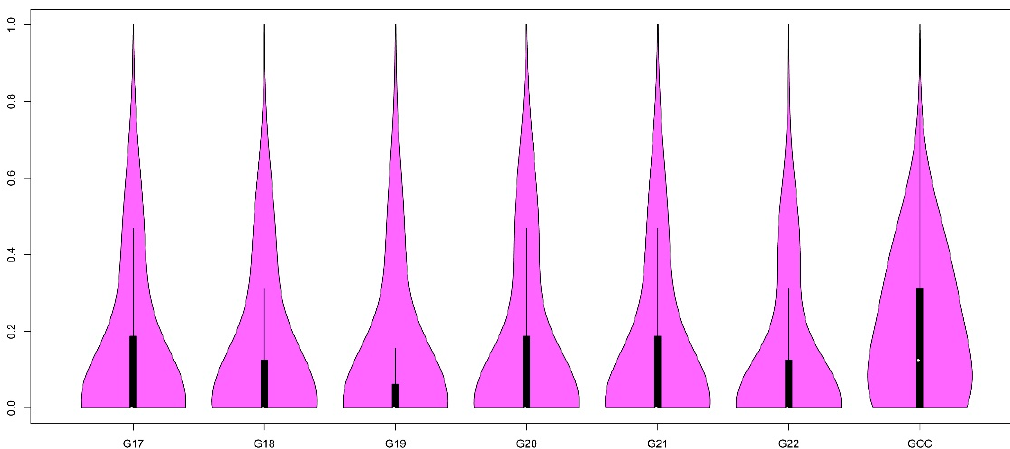
Figure 1. Violin plot showing the distribution of heterozygosity across generations G17 to G22 for inbred Wuzhishan pigs (WZSPs) as compared to non-inbred pigs. x-axis: different generations (G17–G22) in inbred WZSPs and non-inbred pigs (labelled as GCC); y-axis: the values of heterozygosity.